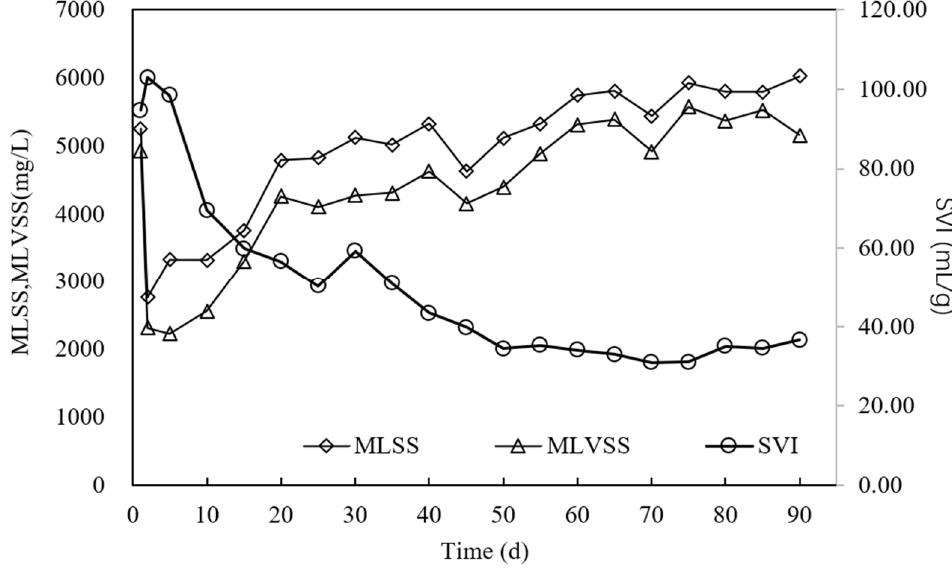
Figure 1. Variation of MLSS, MLVSS and SVI in AGS formation and